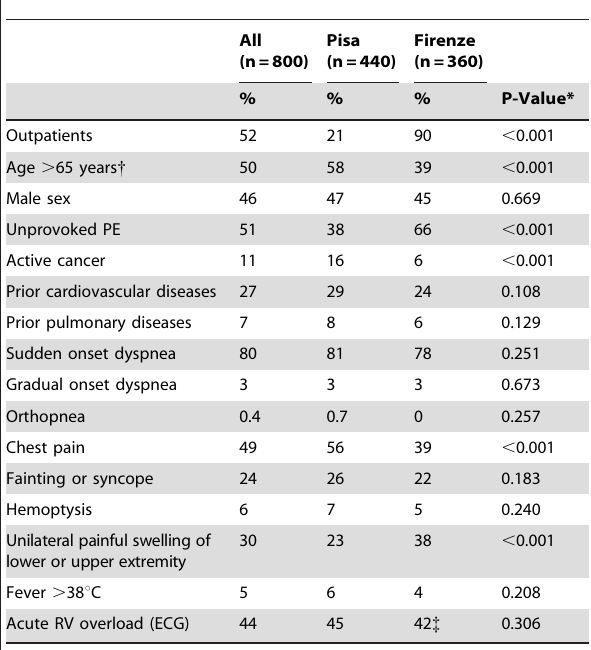
Table 4. Baseline characteristics and prevalence of clinical findings in 800 patients with pulmonary embolism from two different clinical